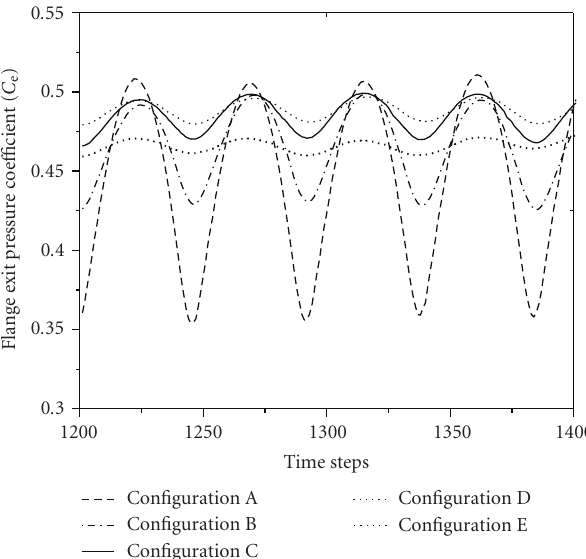
Figure 16: Static pressure coe ffi cient at the exit flange of the fan versus time